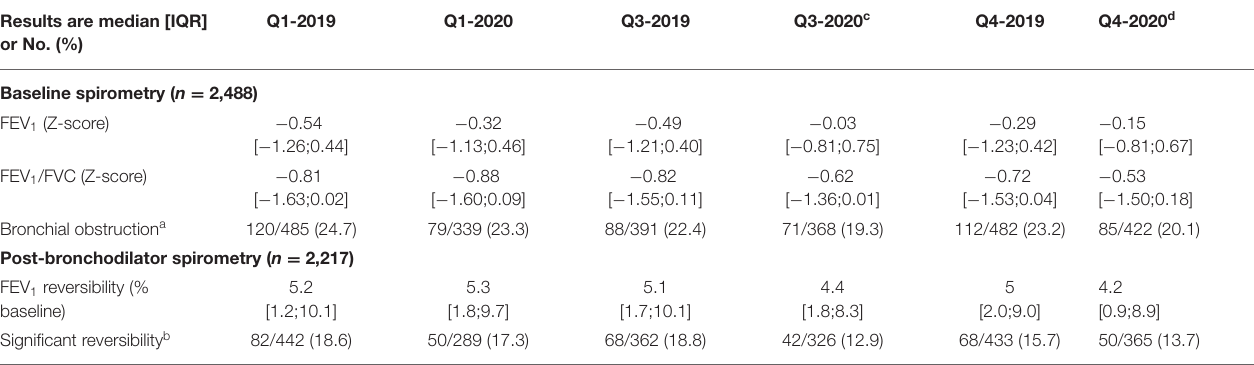
TABLE 1 | Baseline ( n = 2,488) and post-bronchodilator ( n = 2,217) pulmonary function recorded in 2019 and in 2020, according to quarters. Results are median [IQR] or No.